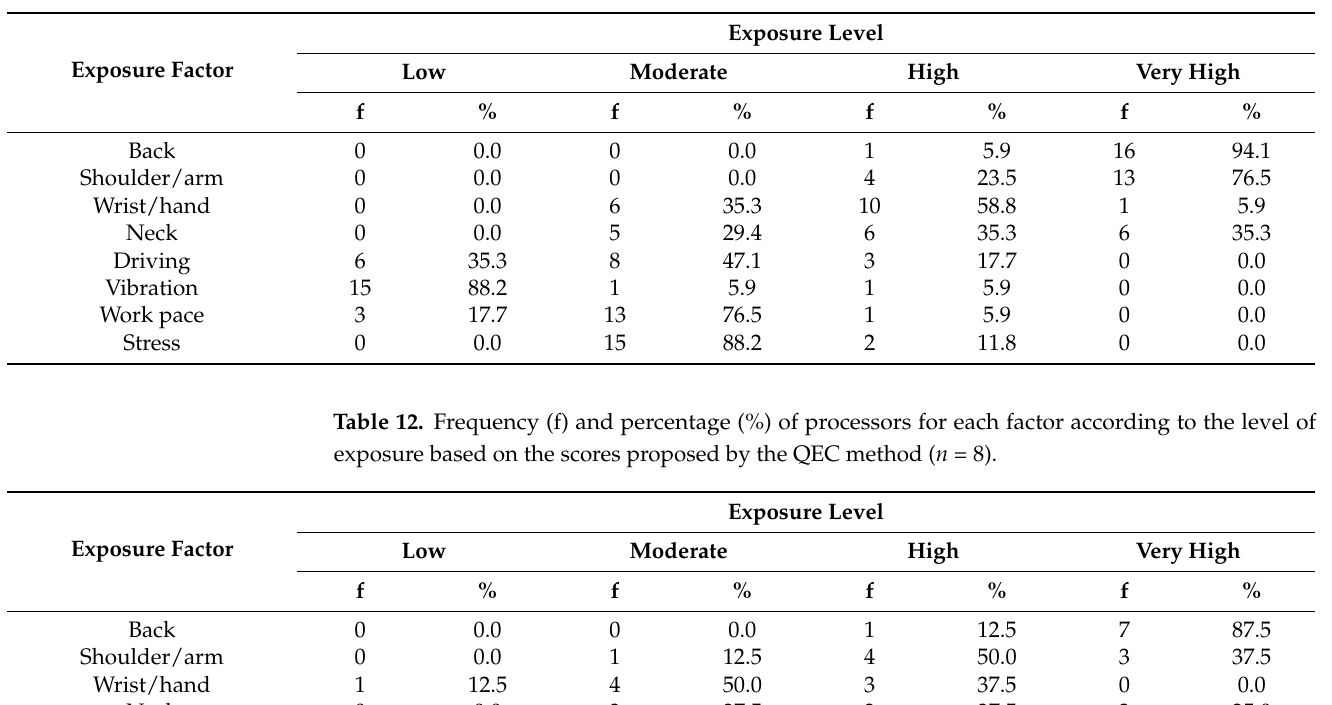
Table 11. Frequency (f) and percentage (%) of pickers for each factor according to the level of exposure based on the scores proposed by the QEC method ( n = 17).